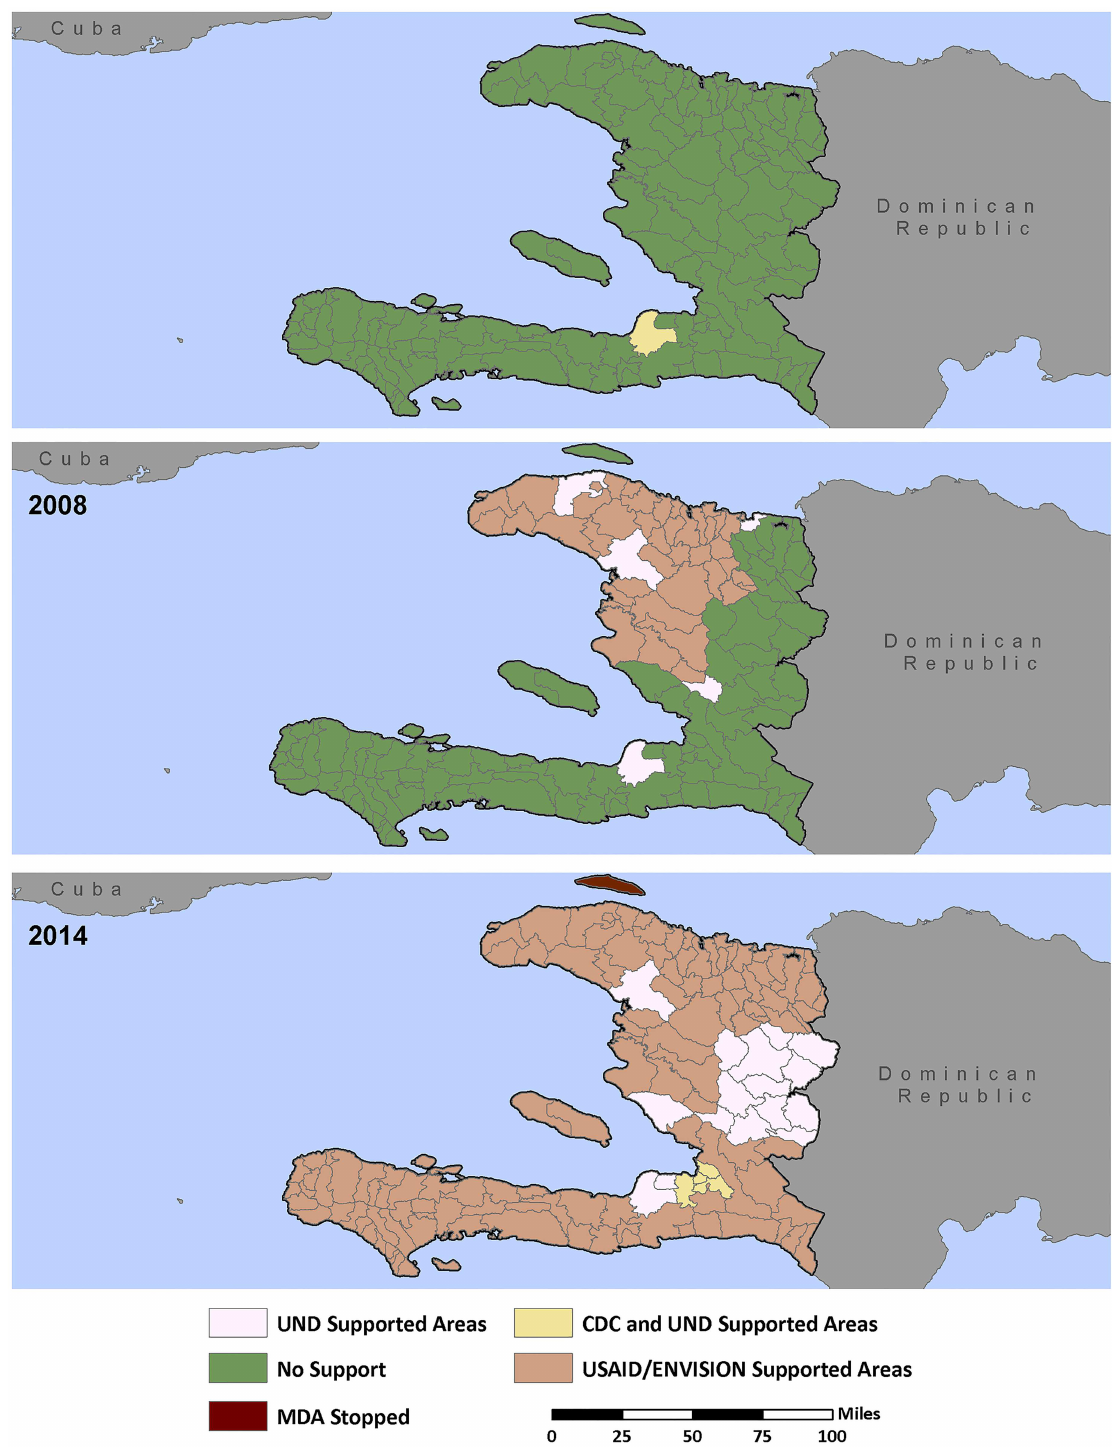
Fig 1. Geographic regions of partner support for the National NTD Program (2000–2014). Data Source: USAID’s NTD Database. Disclaimer: Data may have not yet been approved by at least one level in the USAID NTD data review process.